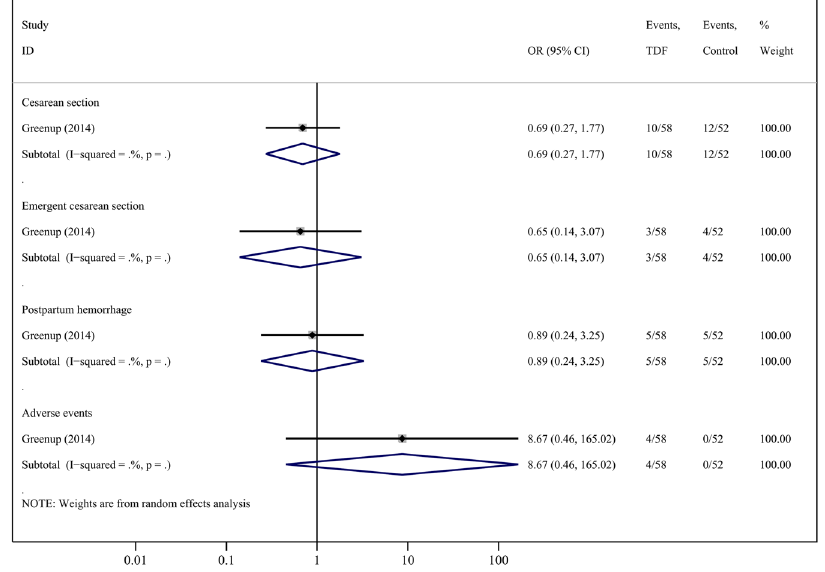
Figure 4. Forest plot showing meta-analysis of maternal outcomes for studies comparing TDF versus LAM at delivery, based upon random-effects model.